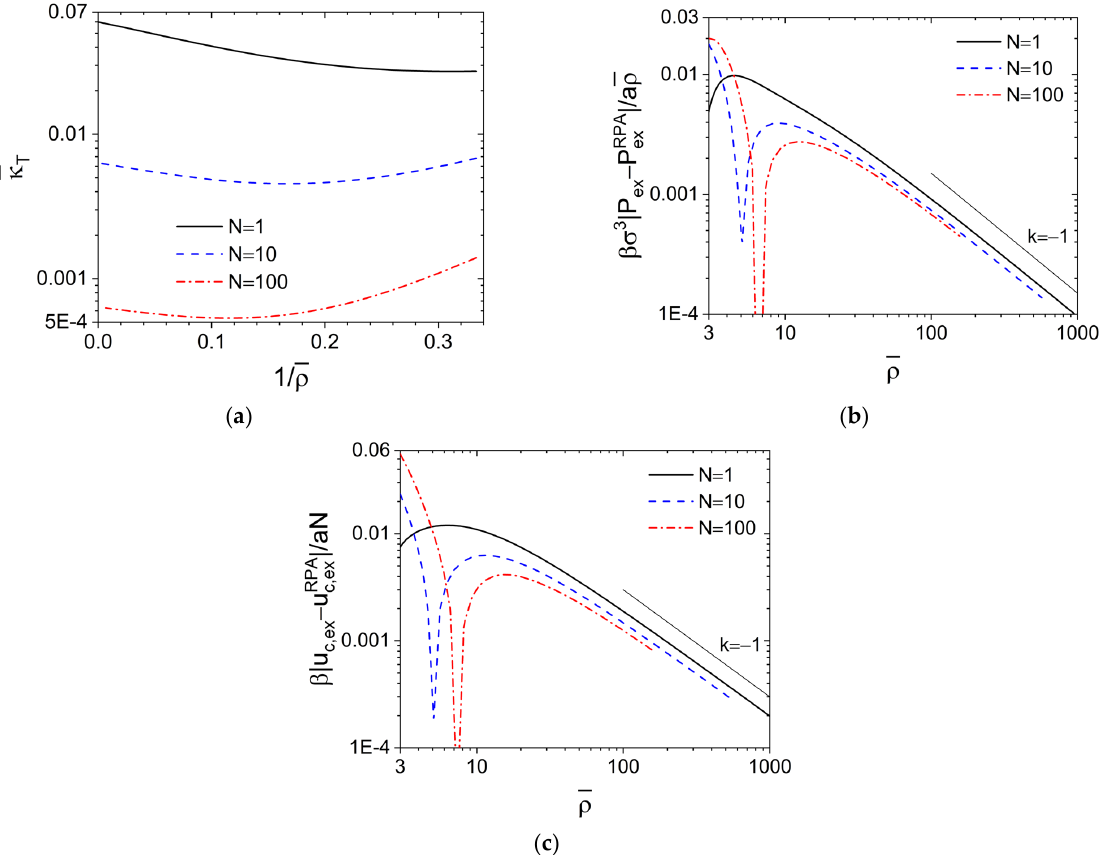
Figure 2. ( a ) Semi-logarithmic plot of the normalized isothermal compressibility κ T and logarithmic plot of the difference between ( b ) the excess (virial) pressure P ex and ( c ) the excess internal energy per chain u c ,ex due to the interchain interactions given by the PRISM-PY calculations and that by the PRISM-RPA calculations of the DPD model at various chain lengths N . The k -value gives the slope of the corresponding straight line. See the main text for more details.